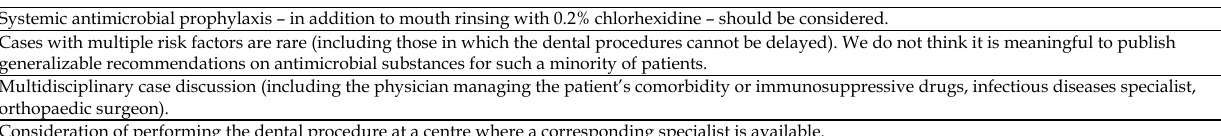
Table 3. Recommendations if multiple risk factors (Table 2) are